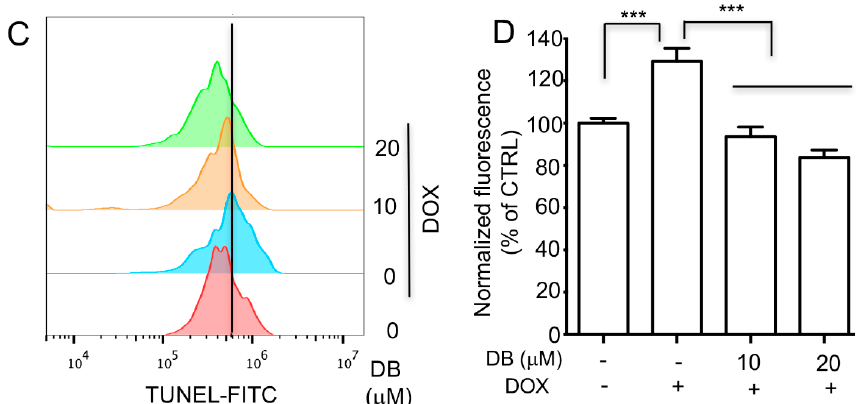
Figure 2. The reversal of DOX-induced apoptosis by DB. ( A ) Nuclear staining of H9c2 cells with Hoechst 33324. Cells pre-treated with DB for 2 h and then co-treated with DOX (1 μ M) for 24 h, the internucleosomal DNA fragmentation was examined using Hoechst 33342. The arrow indicates the cells with the typical characteristics of apoptosis. Bar = 40 μ m; ( B ) H9c2 cells were pre-treated without or with DB for 2 h, followed by incubation with 1 μ M DOX for another 24 h. mitochondrial membrane potential (MMP) was monitored by determining the relative amounts of mitochondrial JC-1 monomers using a fluorescent microscope. Bar = 40 μ m; ( C , D ) Effect of DB on the TUNEL staining index in H9c2 cells after DOX insult. Apoptotic cell death was detected with TUNEL staining by using flow cytometry. Data represent the mean ± SD ( n = 3) and were analyzed by ANOVA. *** p < 0.001 for each group versus DOX without DB.